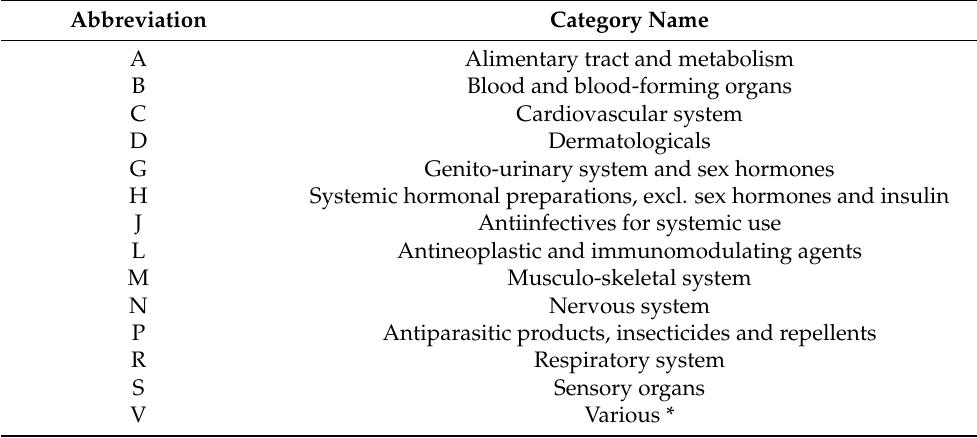
Table 1. Anatomical therapeutic chemical classification